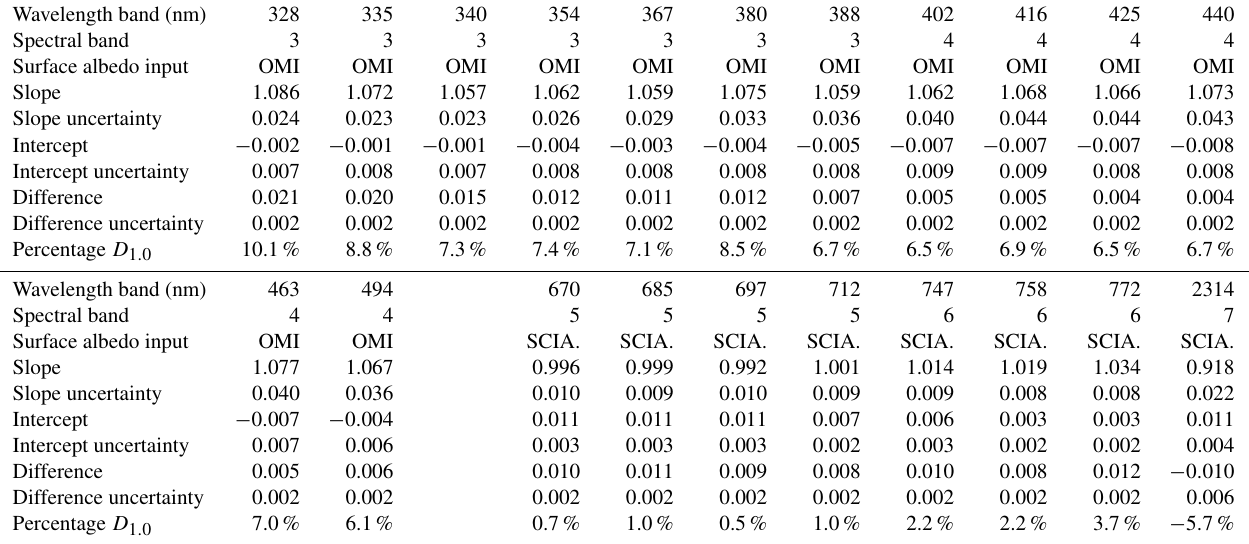
Table 3. Final results from the reflectance validation study described in this paper. For each of the 21 wavelength bands the differences w.r.t. simulations are given. The slopes, intercepts, differences, and their uncertainties are representative for the clear-sky scenes that were studied and best describe the situation for 30 April 2018, the first day after the end of the TROPOMI commissioning phase. The percentage D 1 . 0 deviates from this in that it was determined for the entire time period that was studied (for which it is